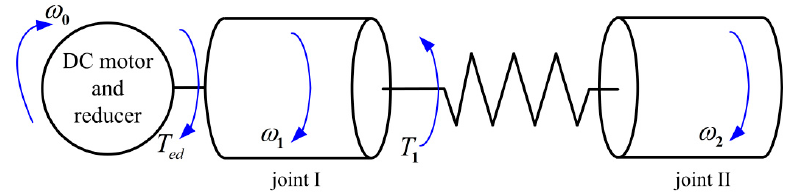
Figure 1. Physical model of the flexible-joint robot system.